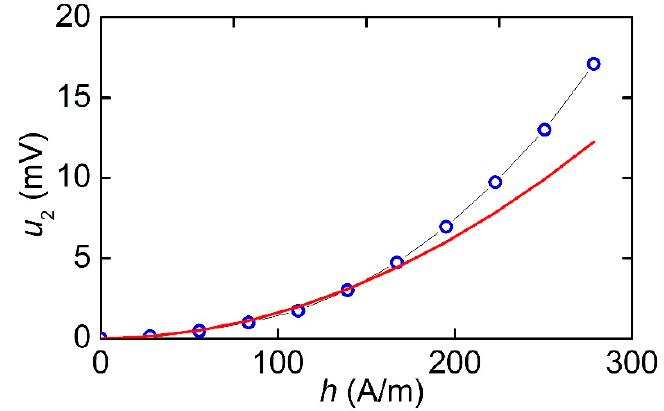
Figure 11. Dependence of the second harmonic amplitude u 2 on the excitation field amplitude h at H = 0 for the М FC-PZT structure with T 1 = 250 µ m. The solid curve is the quadratic approximation of experimental data.